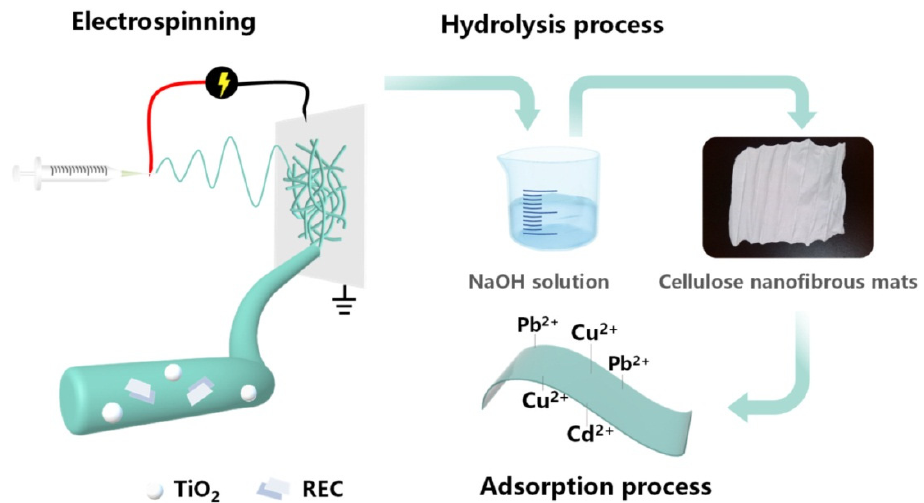
Figure 14. Schematic diagram of preparation of cellulose membrane via electrospinning of cellulose acetate with TiO 2 nanoparticles and rectorite, followed by deacetylation to pure cellulose with increased absorption properties towards heavy metal ions Pb 2+ , Cu 2+ and Cd 2+ (reprinted from International Journal of Biological Macromolecules 2021 , 183 , 245–253, Wang, C.; Zhan, Y.; Wu, Y.; Shi, X.; Du, Y.; Luo, Y.; Deng, H. TiO 2 /rectorite-trapped cellulose composite nanofibrous mats for multiple heavy metal adsorption, with permission from Elsevier).